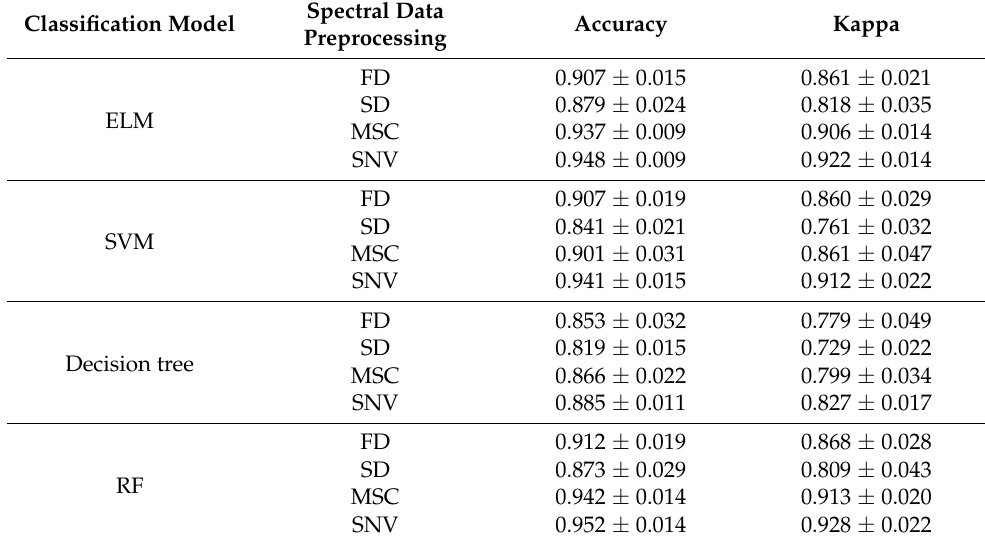
Table 1. SCC staging results based on spectral data. Classification